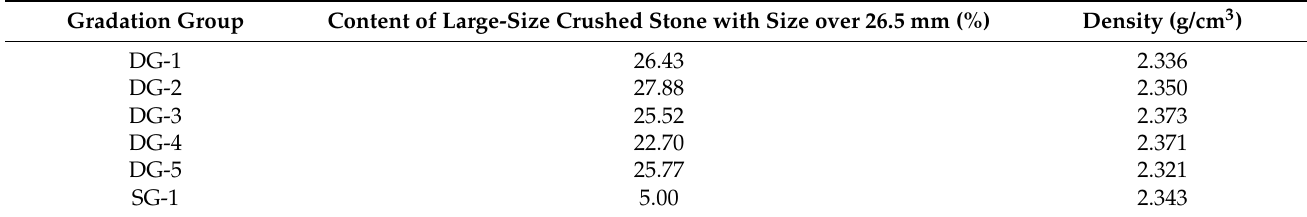
Table 5. Contents and densities of large-size crushed stone